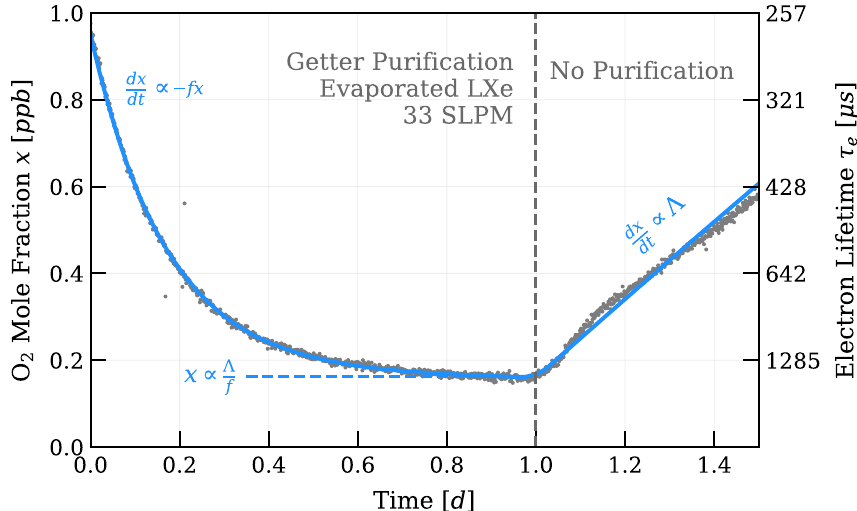
Fig. 5 Model (blue) of PM O 2 mole fraction (gray) in PM-only mode, before and after stopping circulation through the getter (dashed gray vertical line). The data after the change constrains the O 2 source magnitude Λ , and the prior data then constrains f